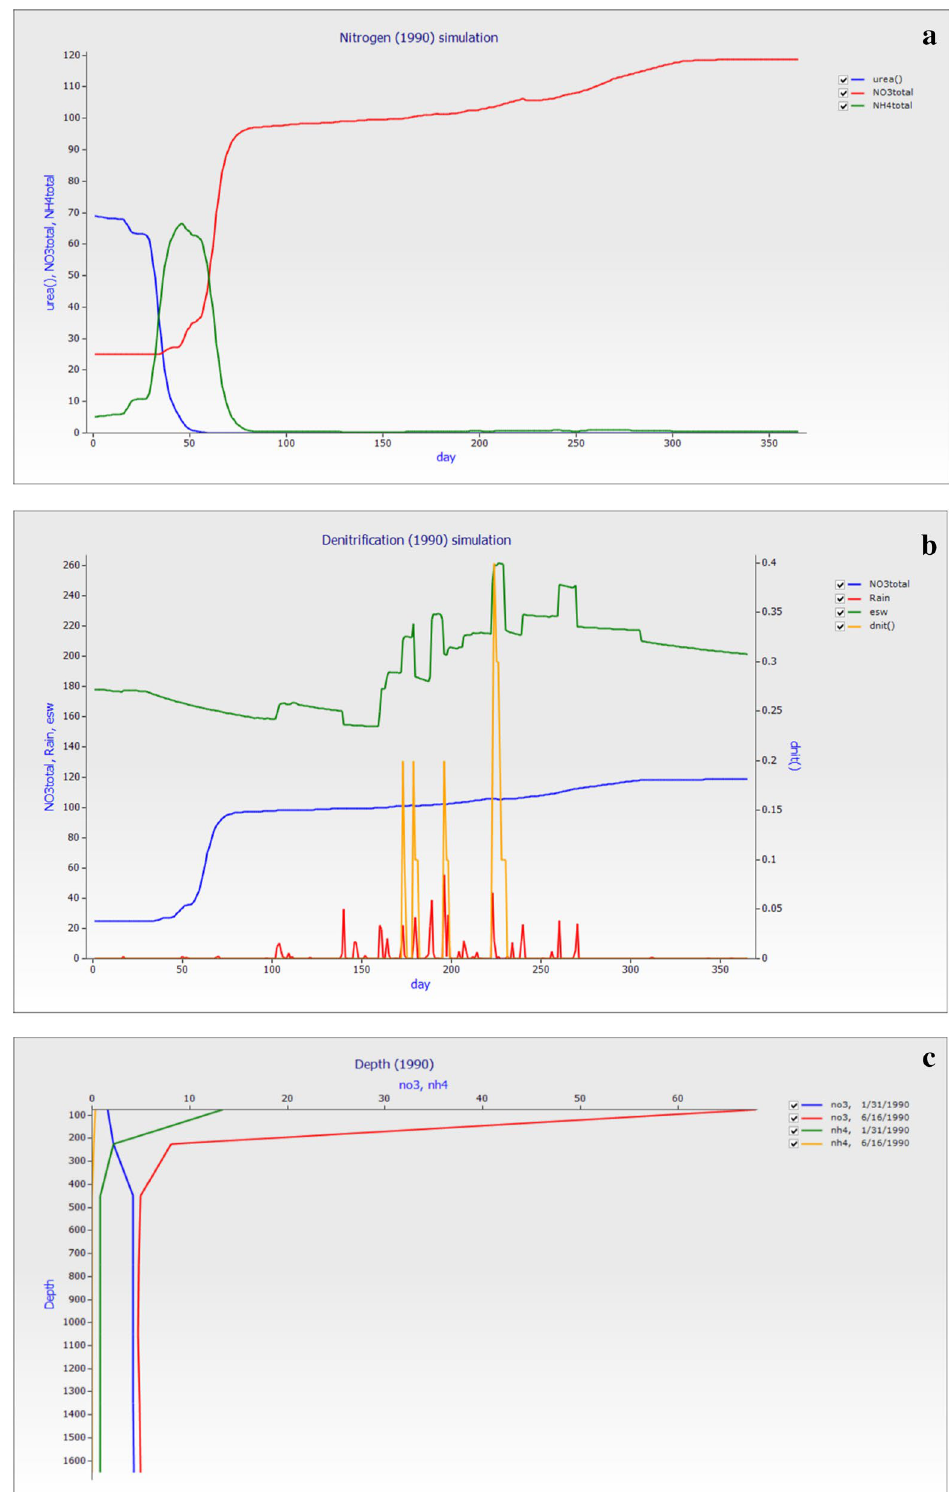
Figure 10. The graph was created on weather data of 1990, and the simulation of NO 3− –N and NH 4+ –N value was change to check the simulation of nitrogen losses with the same weather data. ( a ) nitrogen simulation graph such as days versus total (NO 3− –N and NH 4+ –N) and urea, ( b ) denitrification graph in which days of the years versus denitrification (dnit), rain, esw, and total NO 3− –N while, ( c ) the depth of the profile versus NO 3 and NH 4+ –N with different days of the